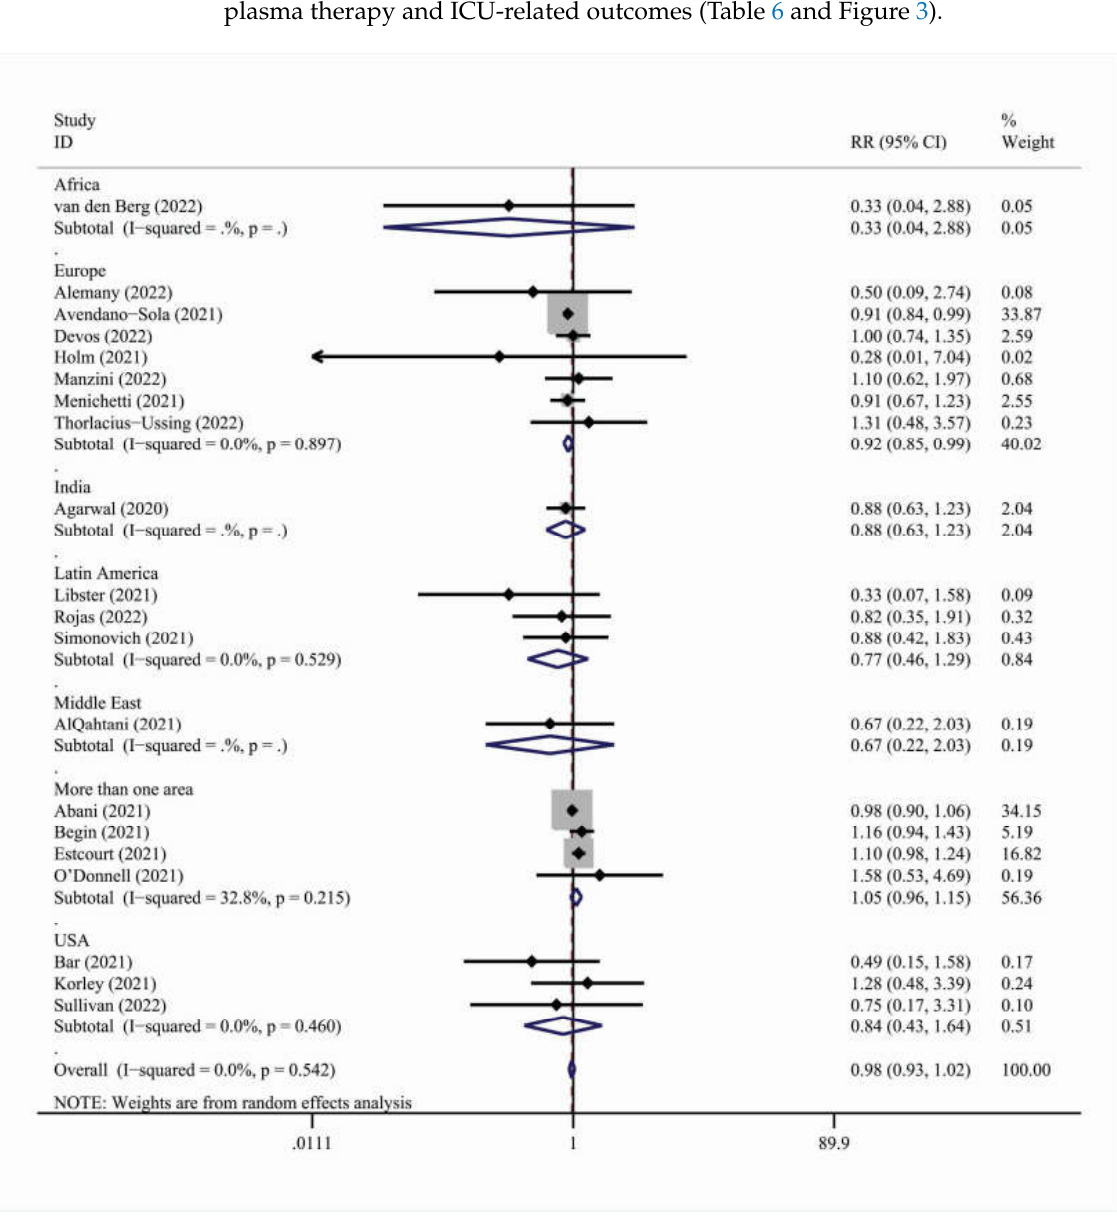
Figure 3. Forest plot describing the association between convalescent plasma treatment and 28-day ICU-related outcomes. Apart from the overall analysis, the subanalysis per geographic region is presented.